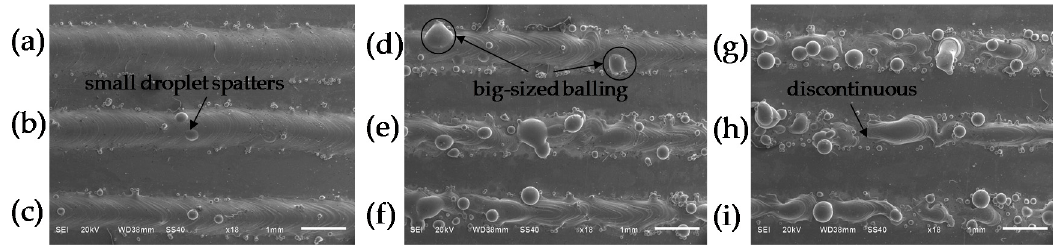
Figure 3. SEM micrographs showing the surface of single scan tracks under different scanning speeds ( P = 400 W, δ = 200 μ m). ( a ) v = 40 mm/s; ( b ) v = 60 mm/s; ( c ) v = 80 mm/s; ( d ) v = 100 mm/s; ( e ) v = 120 mm/s; ( f ) v = 140 mm/s; ( g ) v = 160 mm/s; ( h ) v = 180 mm/s; ( i ) v = 200 mm/s.